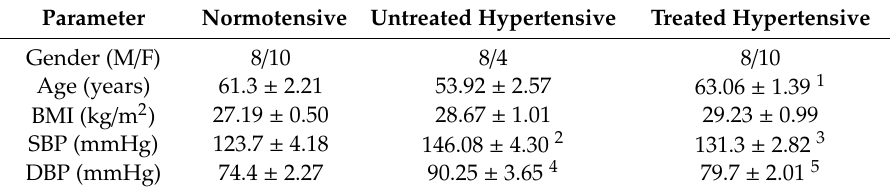
pressure. Table 2. Characteristics of the participants involved in the biochemical analysis.